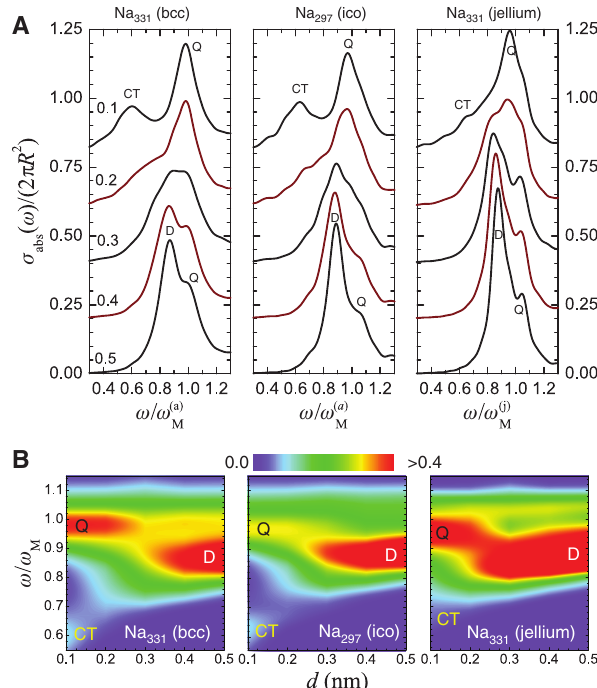
Figure 6: Upper panels: Waterfall representation of the normal- ized optical absorption cross section for the bcc-Na and jellium-Na dimers. The spectra have been shifted to ease the 331 comparison between the different regimes. The separation d (in Å) is indicated in the left panel. Lower panels: Corresponding contour plots of the normalized absorption spectrum.